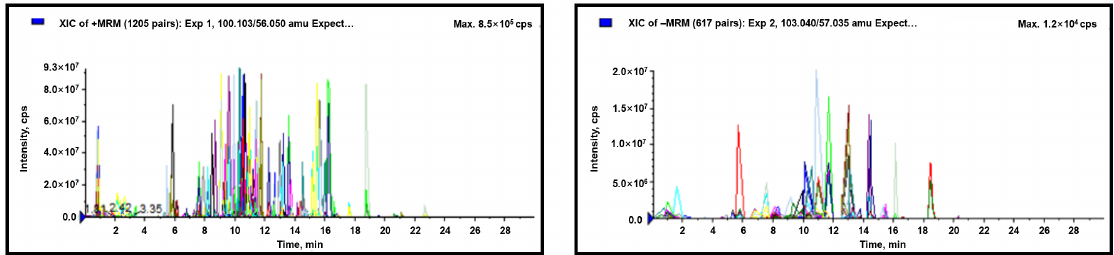
Figure 1. Multi-peak plot of metabolites in MRM (multiple reaction monitoring) detection. Each color represents a different metabolite.